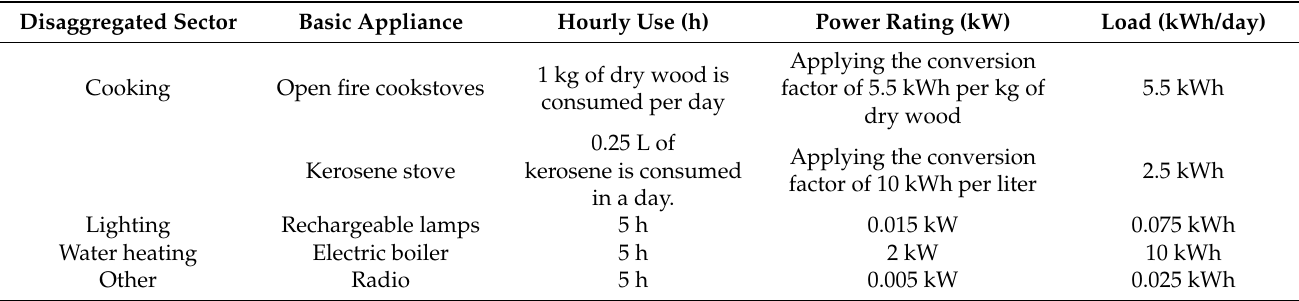
Table 13. Results of the survey on the typology B informal house.